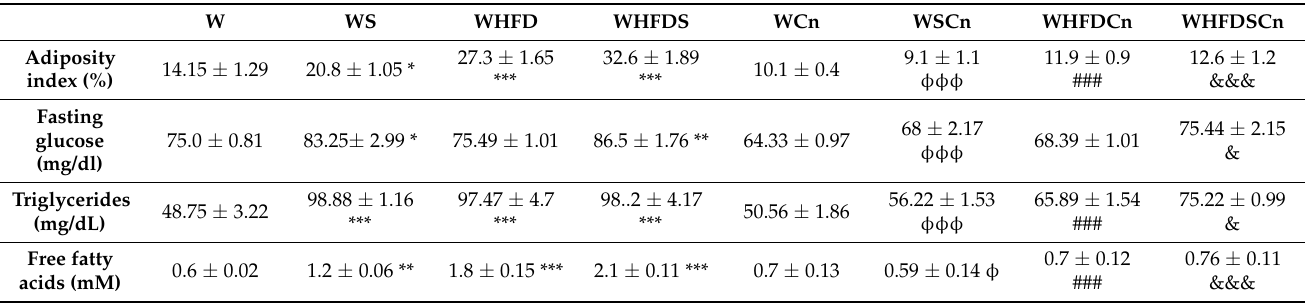
Figure 1. Effects of cinnamaldehyde treatment on: ( A ) body weight; ( B ) total cholesterol; ( C ) TyG index (an insulin resistance marker); ( D ) glycated hemoglobin levels; ( E ) intraperitoneal glucose tolerance test (IPGTT); and ( F ) the glucose area under the curve (AUC) in 8-months-old Wistar (W) rats fed with sucrose (WS), a high-fat diet (WHFD), or both (WHFDS), compared to normal W rats. ( E ). Data are expressed as mean ± SE (n = 12 animals per group). * p < 0.05, ** p < 0.01, *** p < 0.001 vs. W rats; φφφ p < 0.001 vs. WS rats; # p < 0.05, ### p < 0.001 vs. WHFD rats; & p < 0.05, && p < 0.01, &&& p < 0.001 vs. WHFDS rats. Table 1. Effect of cinnamaldehyde treatment on adiposity index, fasting blood glucose, triglycerides and free fatty acid levels in W control rats, W fed with sucrose (WS), high-fat diet (WHFD), or both (WHFDS).